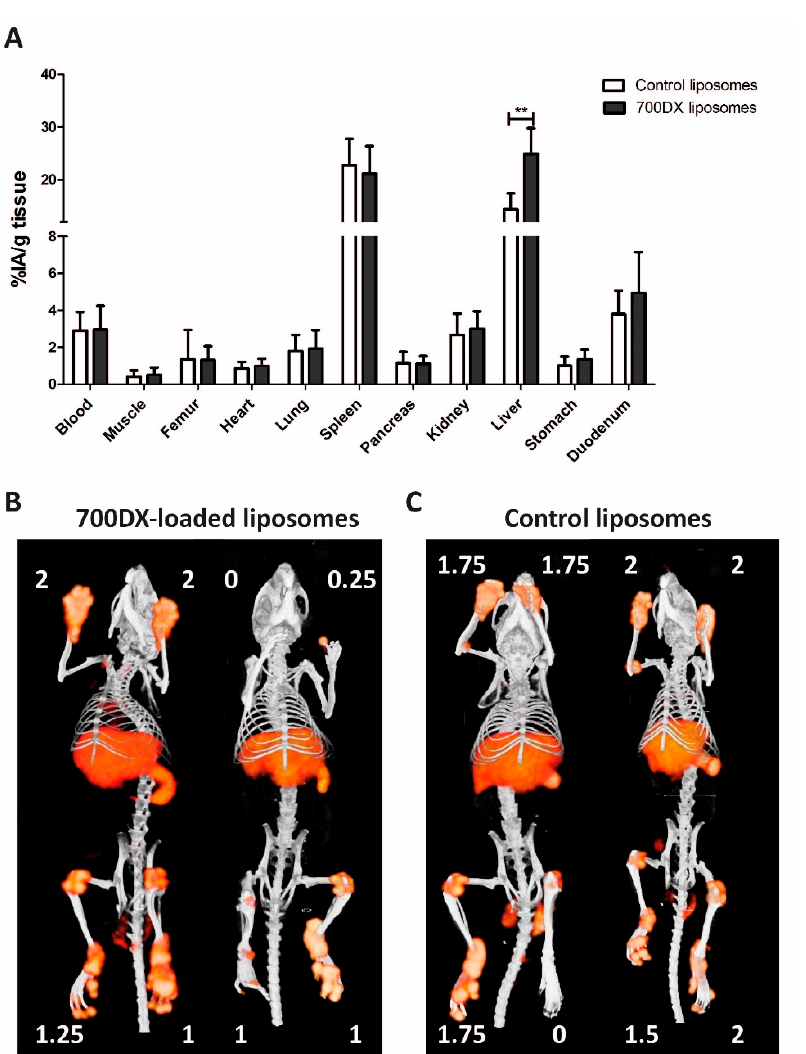
Figure 2. ( A ) Biodistribution of liposomes with or without IRDye700DX. ( n = 10 mice/group). ( B ) SPECT images of mice after injection of 111In-labeled IRDye700DX-liposomes. ( C ) SPECT images of mice after injection of 111 In-labeled control liposomes. Arthritis scores are depicted in white next to the respective joints. (** = p < 0.01).